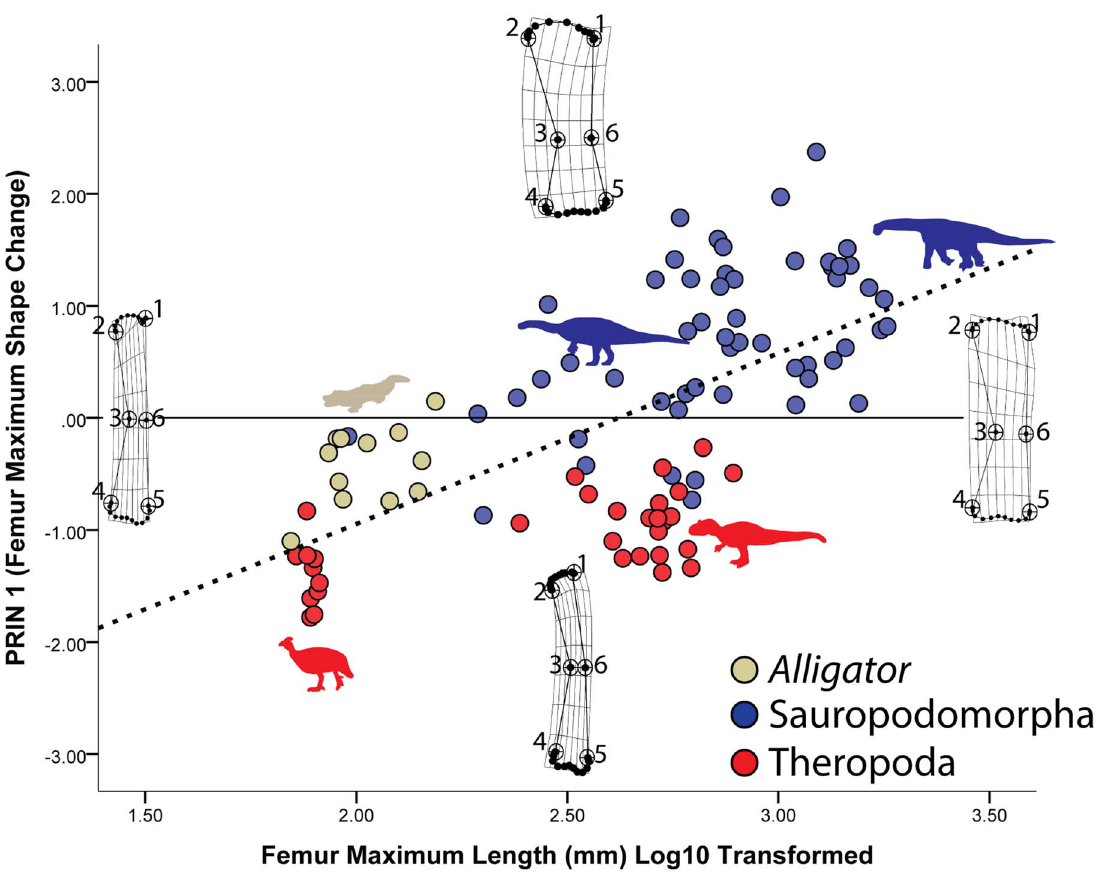
Figure 6. Changes in femur shape saurischian dinosaurs and alligators. Maximum femur shape change in the sample is shown on the Y-axis (PRIN 1), whereas femur shape changes associated with size are shown on the X-axis. As with the humerus, changes in femur shape along the PRIN 1 axis and X-axis are similar in that larger taxa have more proximally and distally expanded ends. Overall, the sub-articular region expands tremendously whereas its overall shape remains gently convex, although the distal condyles become somewhat more pronounced.